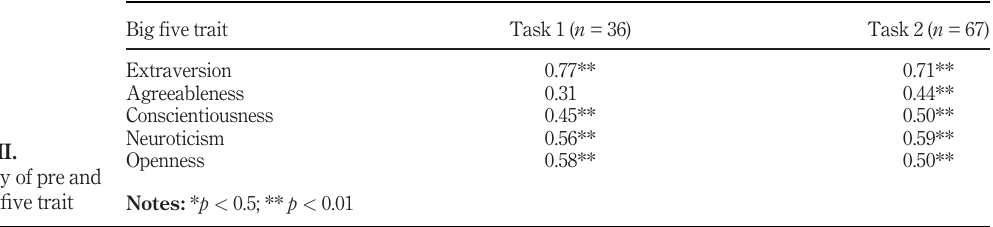
Table II. Summary of pre and post questionnaire